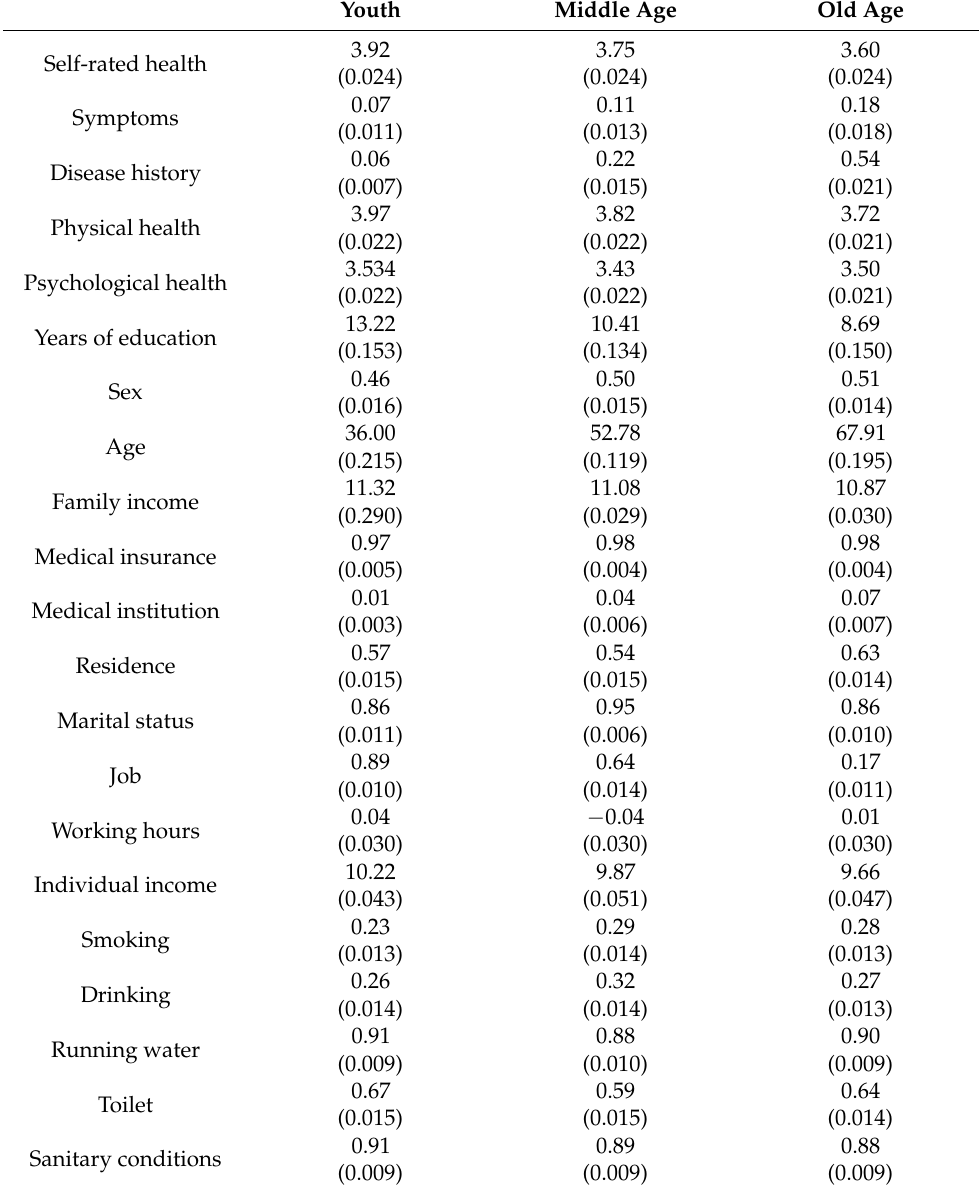
Table A1. Summary statistics of physical and psychological health (by